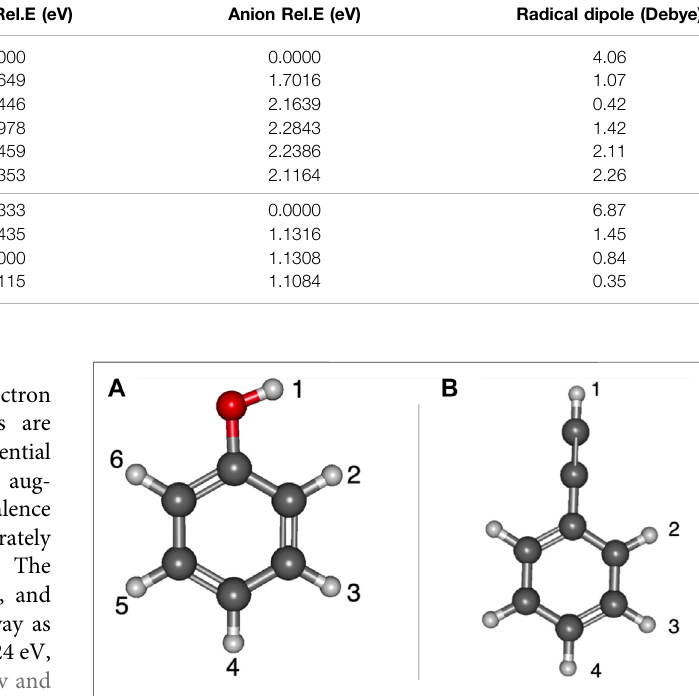
FIGURE 1 | Optimized structures of phenol and ethynylbenzene with numbered positions of deprotonation: (A) phenol, (B)